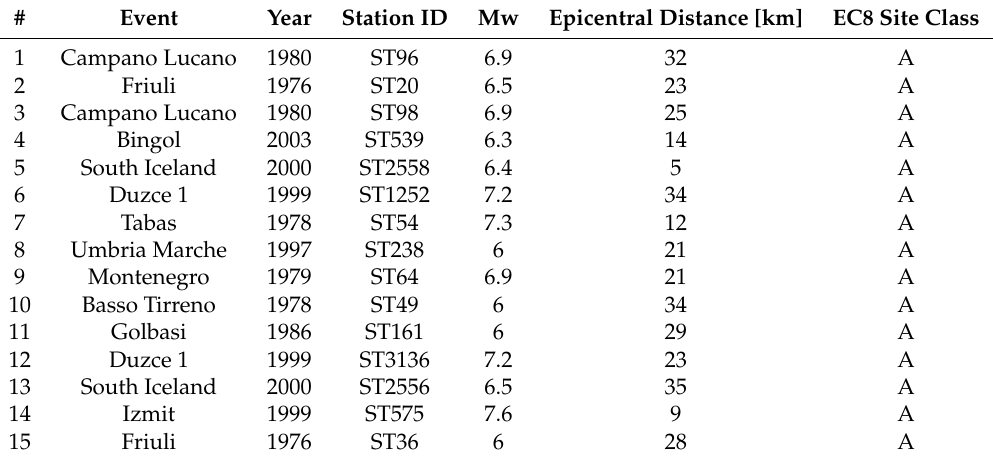
Table 4. Ground Motion